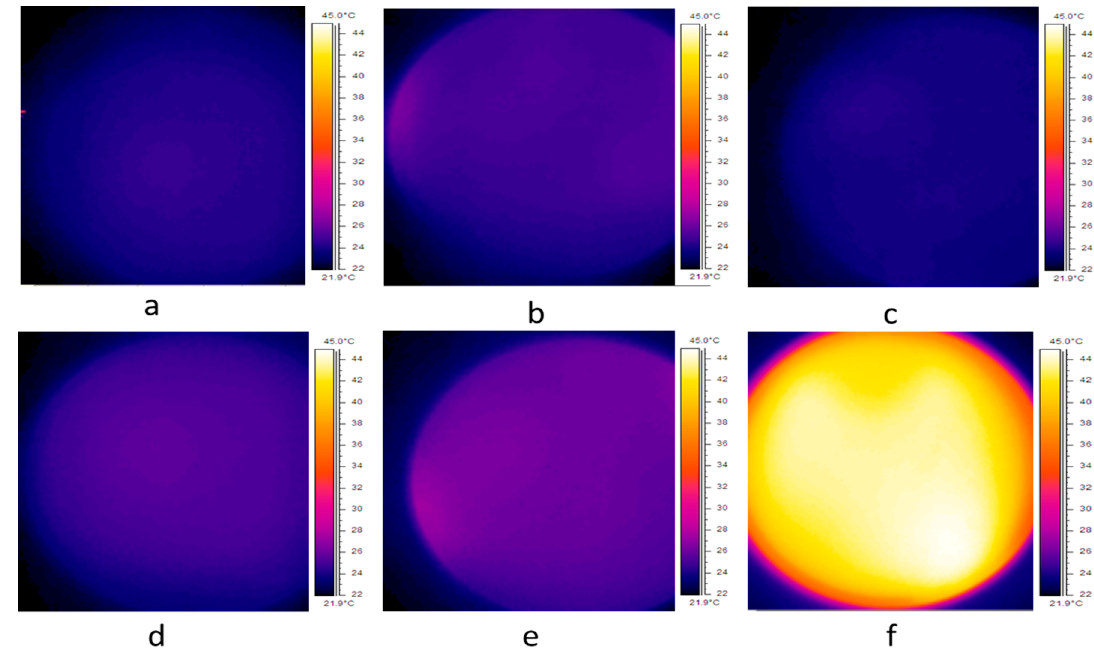
Figure 3. Thermal profile for ( a ) 10 6 A431 cells only; ( b ) solution of coated MNPs immediately after 15 min of AMF treatment; ( c ) 10 6 A431 cells after 15 min of AMF treatment; ( d ) 10 6 A431 cells incubated with coated MNPs after 15 min of AMF treatment; ( e ) 10 6 A431 cells with coated MNPs after 40 min of AMF treatment and ( f ) 10 6 A431 cells after 5 min on a hot plate set to 45 ◦ C. Images taken by thermal imaging camera.